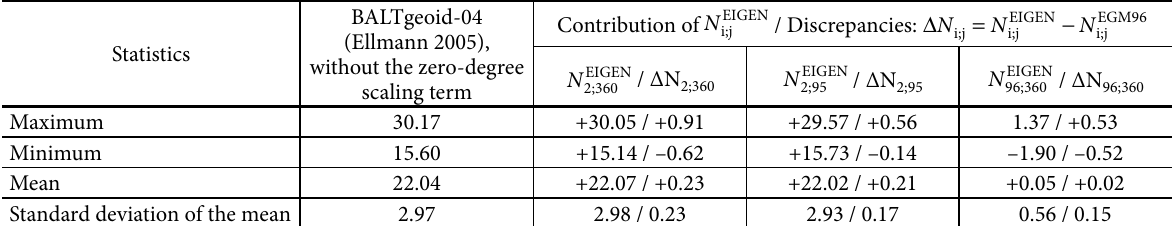
Table 2. Numerical statistics of the selected spectral windows ( EIGEN discrepancies with the EGM96. Units are in metres